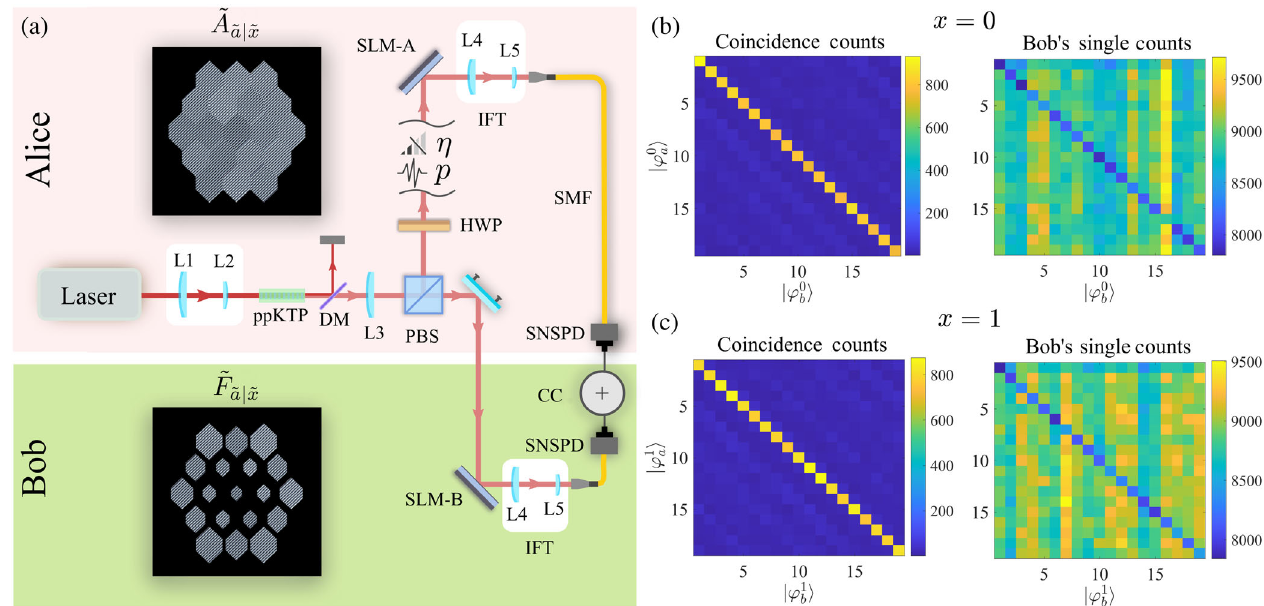
FIG. 3. Experimental setup. (a) ATi:sapphire pulsed laser at 775 nm is used to pump a nonlinear ppKTP crystal to generate a pair of photons entangled in their transverse position momentum via type-II spontaneous parametric down-conversion. The pump photons are filtered by a dichroic mirror (DM) and the down-converted photons are separated with a polarizing beam splitter (PBS). One photon from the entangled photon pair is sent to the untrusted party, Alice, who generates holograms on a spatial light modulator (SLM-A) to ˜ A ˜ a from Alice, forming the perform the projective measurements ˜ a j ˜ x ; see Eq. (2). Bob receives the other photon along with the outcome ˜ F . He then performs the projective measurements assemblage σ ˜ a ˜ a j ˜ x [Eq. (3)] according to the steering inequality defined in Eq. (1). j ˜ x Each of the photons in the selected mode are collected by a combination of telescope lenses (L4 and L5) into single-mode fibers (SMFs) and are detected by superconducting nanowire detectors (SNSPDs). Coincident detection events corresponding to joint two-photon measurements are recorded by a coincidence counting logic (CC) with a coincidence window of 0.2 ns. (b),(c) Experimental data showing coincidence counts between Alice and Bob and exclusive single counts measured on Bob ’ s side in dimension d ¼ 19 using MUB measurement settings x ¼ 0 ,